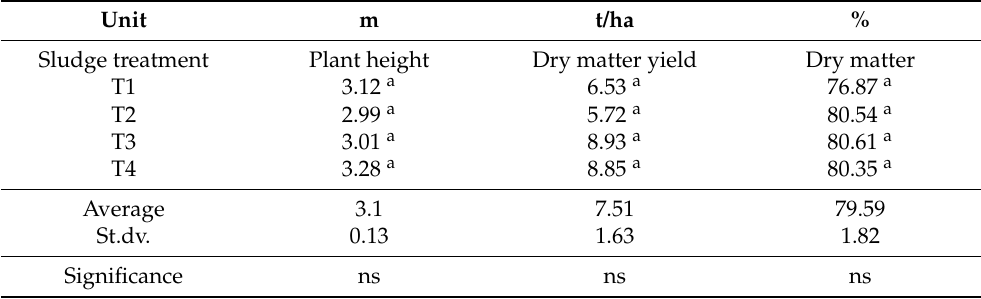
Table 4. Yield results and yield components of Virginia mallow after application of different amount of sewage